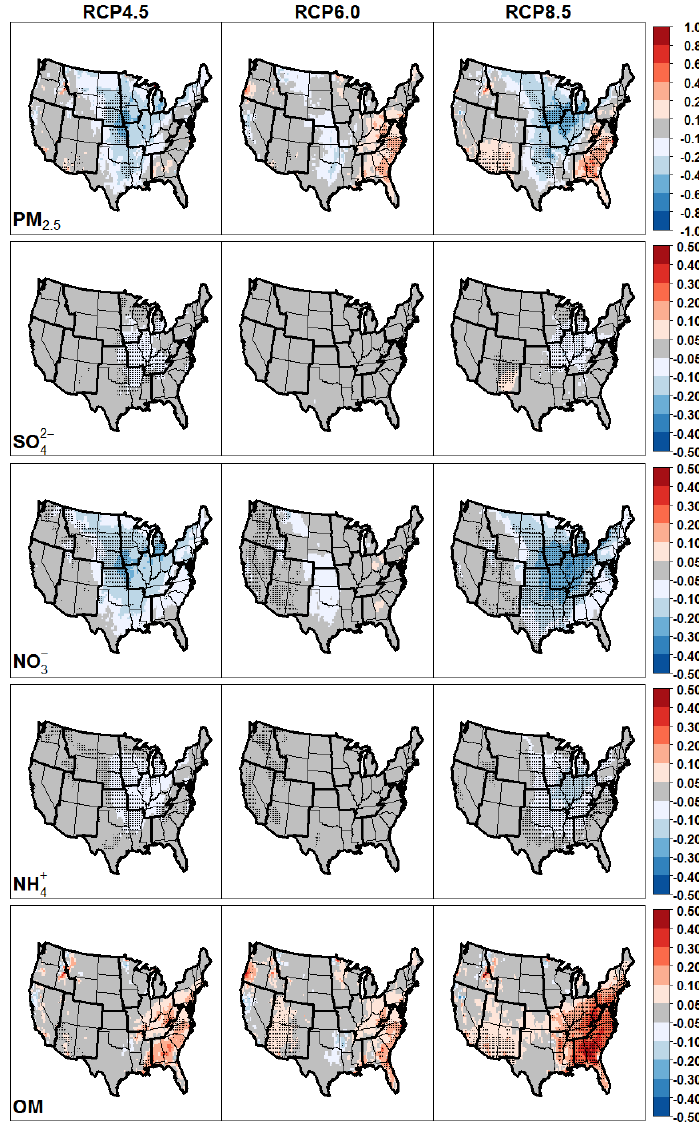
Figure 7. Projected changes in annual mean concentrations (µgm − 3 ) of total PM 2 . 5 and principal PM 2 . 5 components from 1995–2005 to 2025–2035 under RCP4.5, RCP6.0, and RCP8.5. Dark pixels indicate where differences are significant according to Student’s t test ( p < 0 . 05).